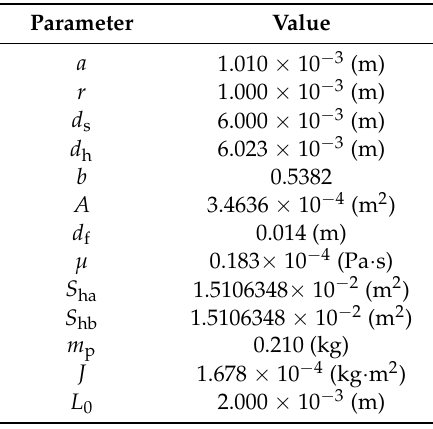
Table 2. Known model parameters.